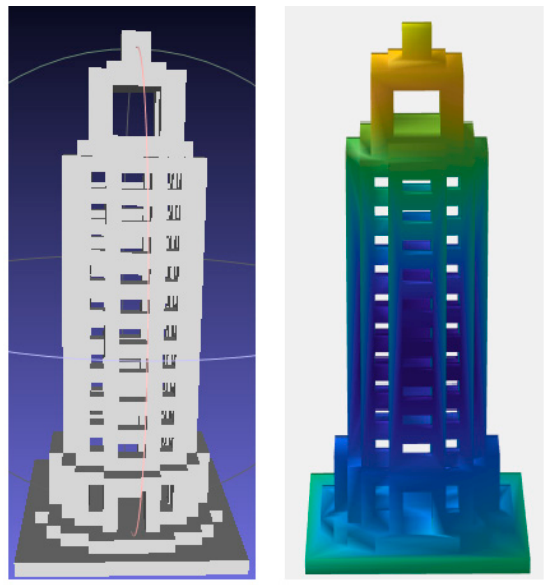
Figure 2. A 3D Skyscraper object (left) and wave kernel signature (WKS) (right).